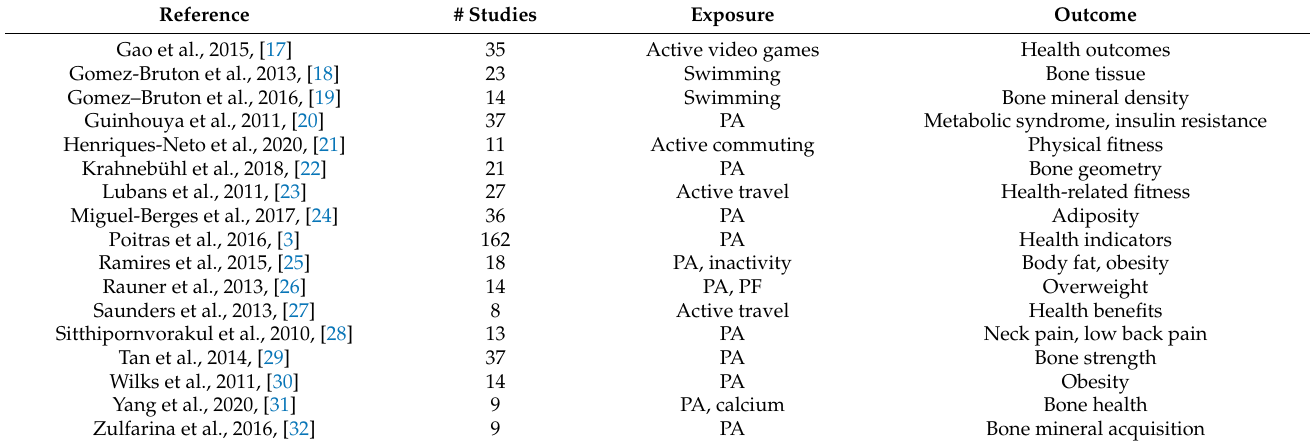
Figure 1. Flow-chart literature search and study selection process * Reasons for exclusion: no systematic review (e.g., conference paper, mini review . . . ; 26), no physical health indicator (4), no PA or SED measure (4), special population (2), wrong age (4), missing information (3), and wrong focus, e.g., comparison of training effects (7). Table 1. Characteristics of the included reviews including studies on effects of